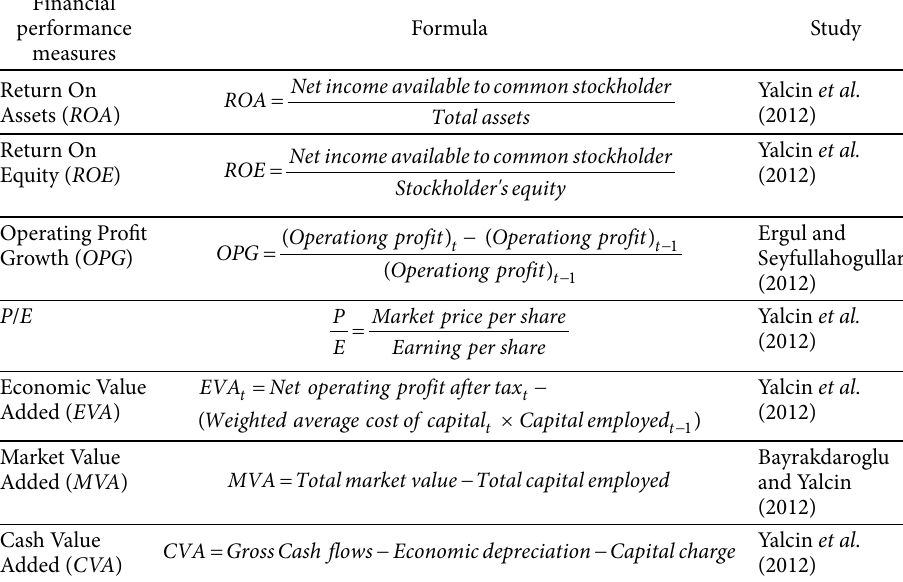
Table 2. Formulation of financial performance evaluation